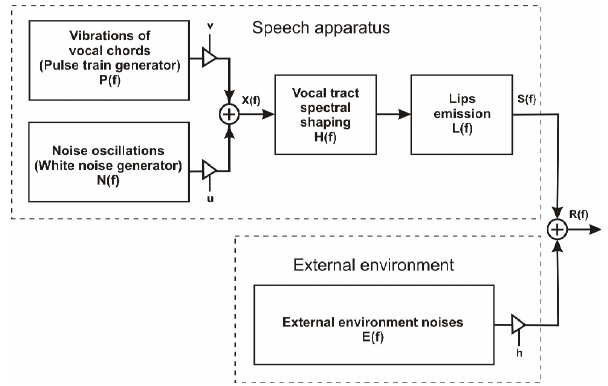
Figure 1: The simplified speech production